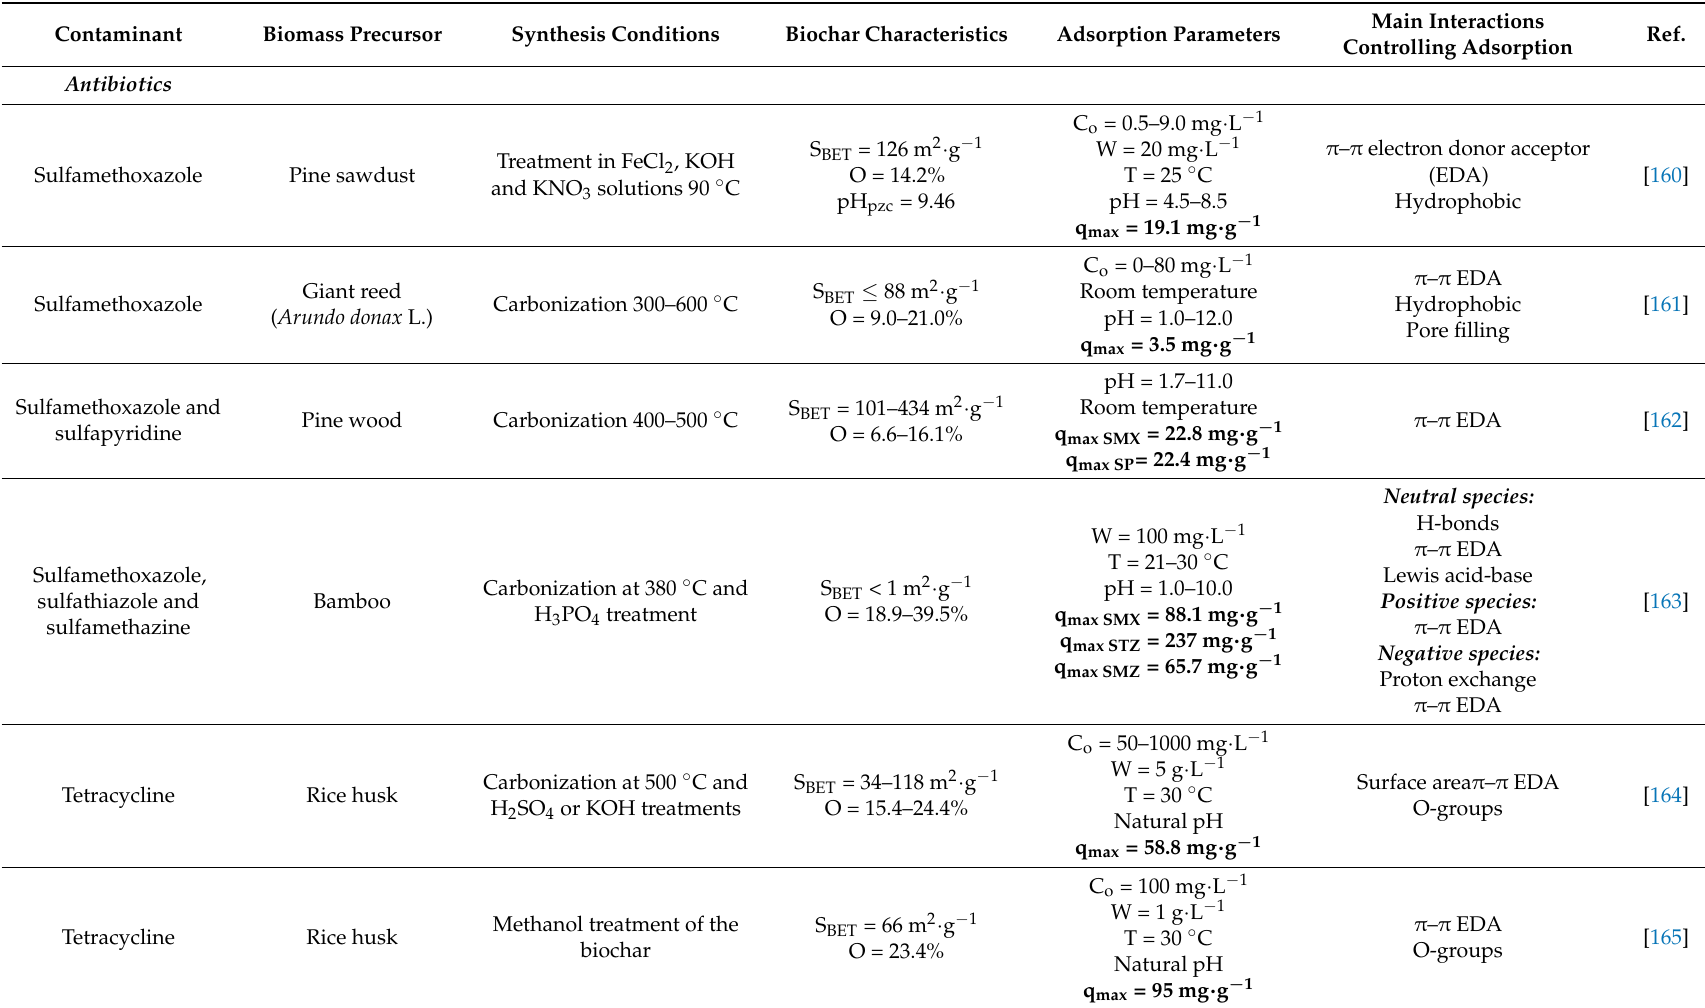
Table 5. Summary of representative works in the literature on adsorption of emerging contaminants from water with